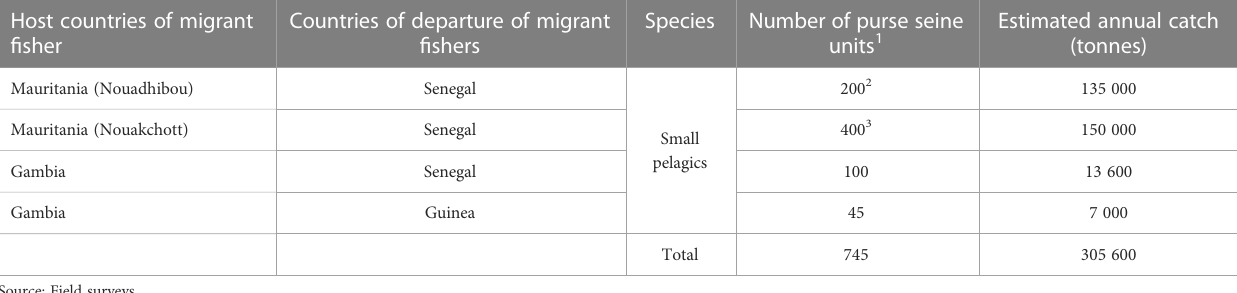
TABLE 2 Estimation of annual catches of migratory small pelagic species in The Gambia and Mauritania over the period 2012 - 2018 13 . Host countries of migrant Countries of departure of migrant Species Number of purse seine fi sher fi shers units